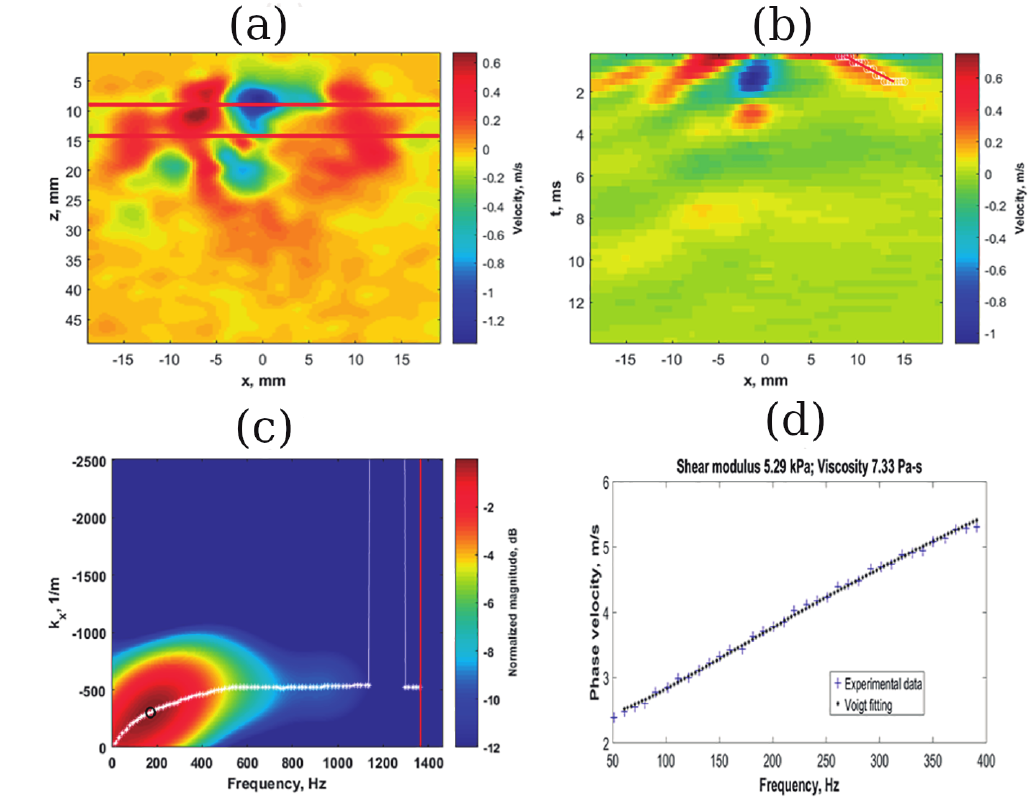
Figure 4. An illustrative process for the estimation of the viscosity parameter of a malignant mass. ( a , b ) Maps of particle velocity; ( c ) a k-space map displaying the phase velocity with the energy of each frequency; ( d ) the final result as a dispersion curve, based on the phase velocity, which is fitted using a Voigt model for estimation of viscoelastic parameters. Source: PLoS ONE, modified from 2018 Kumar et al.